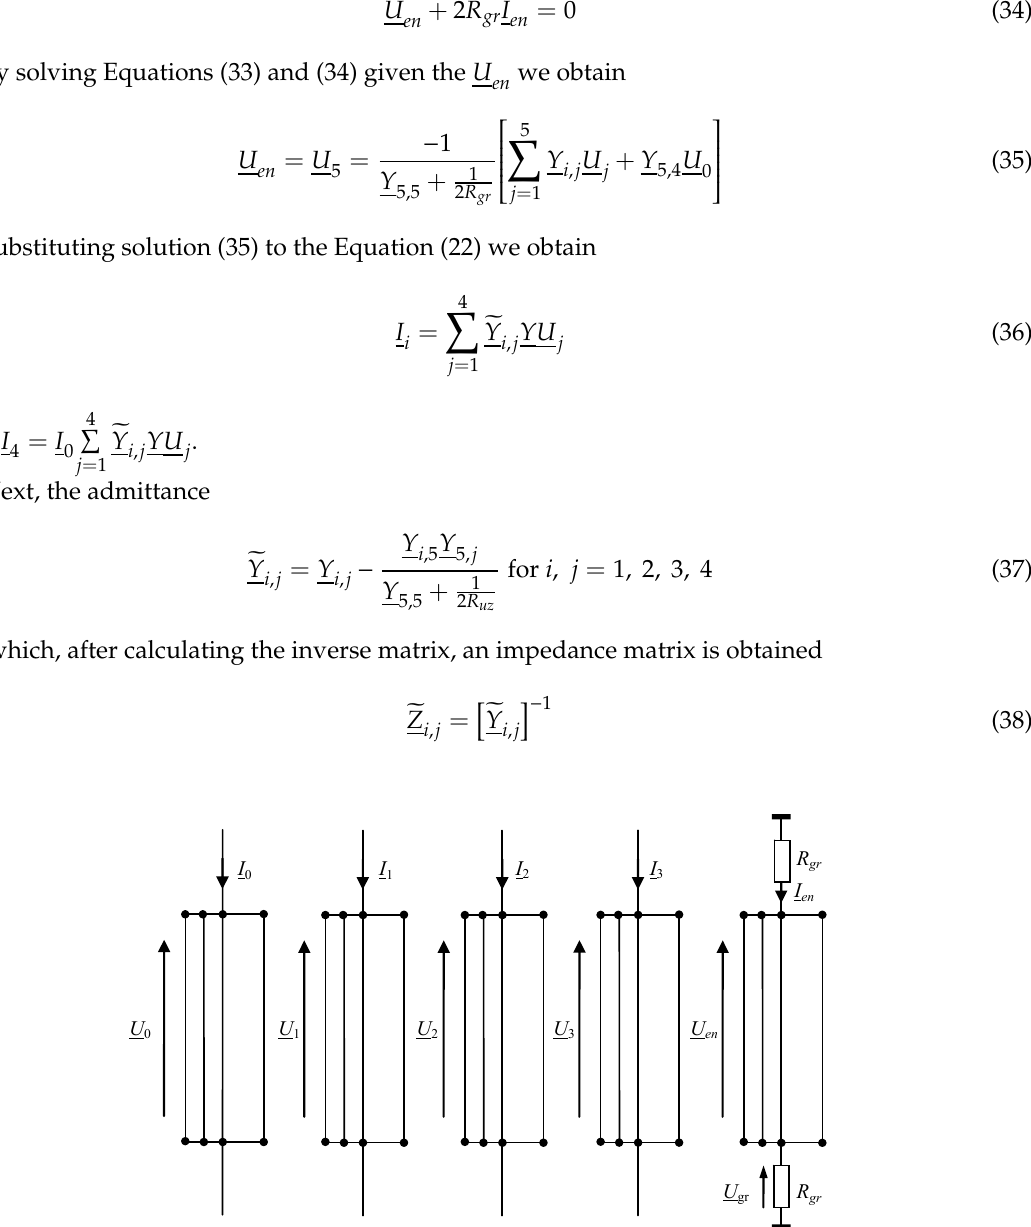
Figure 7. Measurement stand: 1—busbar manufactured by the Holduct company [5], 2—shield cover, 3 —current transformer, 4—Rogowski coils, 5—voltmeter, 6—phase meter, 7—PC with measurement software. The impedances of the busbars were determined by the following methods: the analytical method (AM) previously described [1,3,29] for simple configurations of unshielded busbars neglecting skin and proximity effects, the integral equation method (IEM) based on integral 3 7